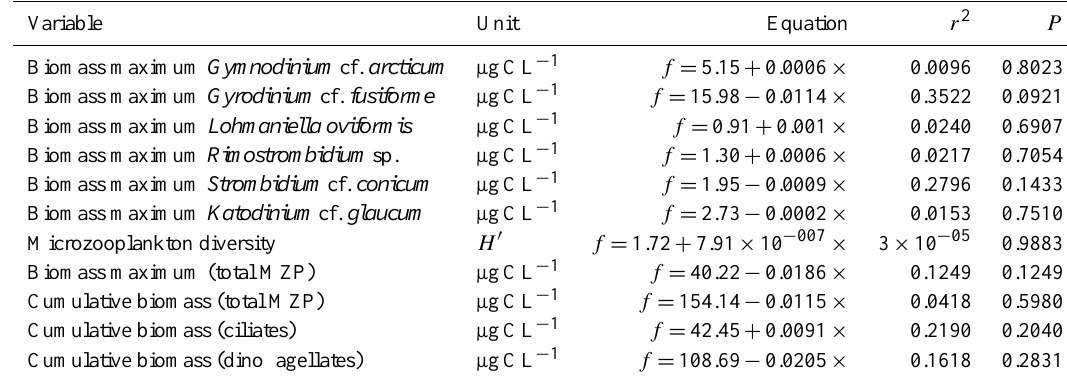
Fig. 1. Microzooplankton (MZP) biomass (µgCL − 1 ) and chlorophyll a concentrations (µgCL − 1 ) in the different p CO 2 treatments (blue Fig. 1: Microzooplankton (MZP) biomass (µg C L -1 ) and chlorophyll a concentrations (µg C L -1 ) in the different p CO 2 treatments (blue lines: p CO 2 of lines: p CO 2 of 175 (A) , 180 (B) and 250 (C) ; grey lines: p CO 2 of 340 (D) , 425 (E) and 600 (F) ; red lines: p CO 2 of 675 (G) , 860 (H) and 175 (A), 180 (B) and 250 (C); grey lines: p CO 2 of 340 (D), 425 (E) and 600 (F); red lines: p CO 2 of 675 (G), 860 (H) and 1085 (I)). 1085 (I) ). Table 1. Regressions of microzooplankton response variables on p CO 2